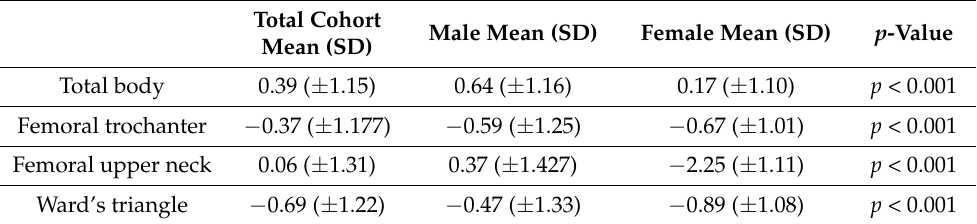
Table 3. Summary of BMD T-score measurements between males and